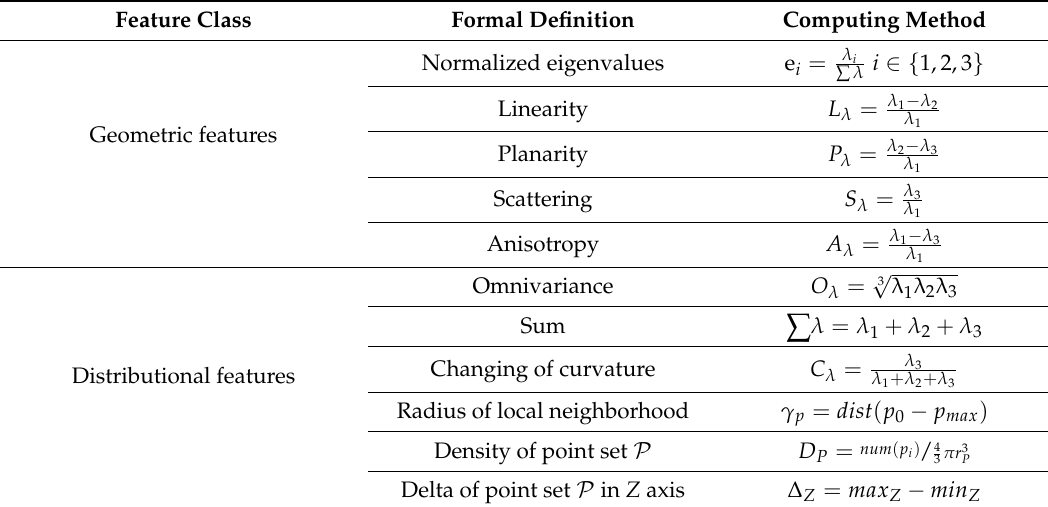
Table 2. A partial list of geometric features and distributional